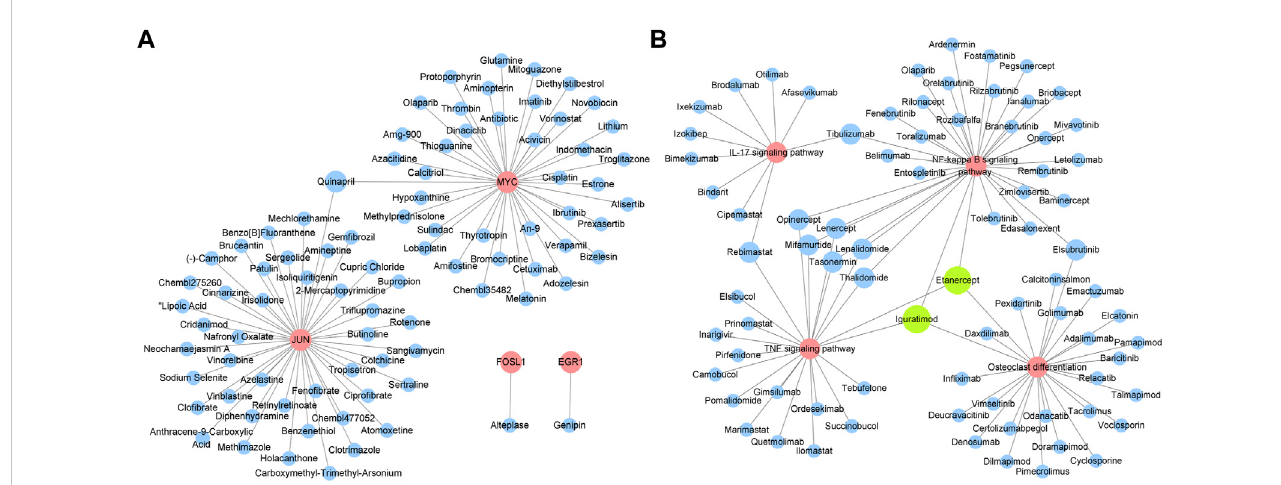
FIGURE 8 Identi fi cation of potential drugs for OA. (A) Drugs targeting hub genes. Red circles represent genes, blue circles represent drugs. (B) Drugs targeting top four KEGG pathways. Red circles represent pathways, blue circles represent drugs. Green circles represent drugs which have three targets.